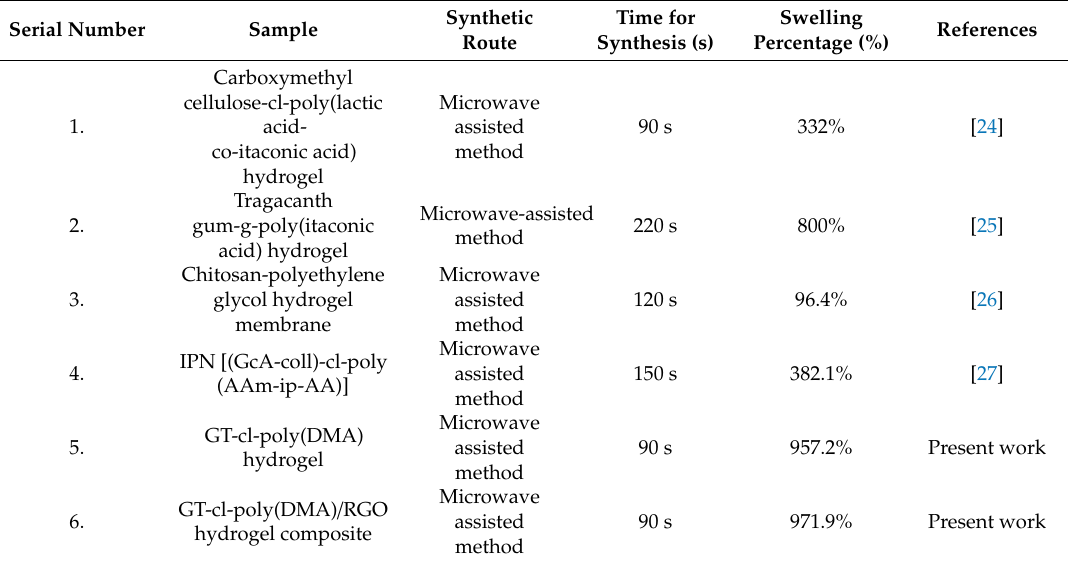
Table 2. Comparative analysis for swelling percentage of